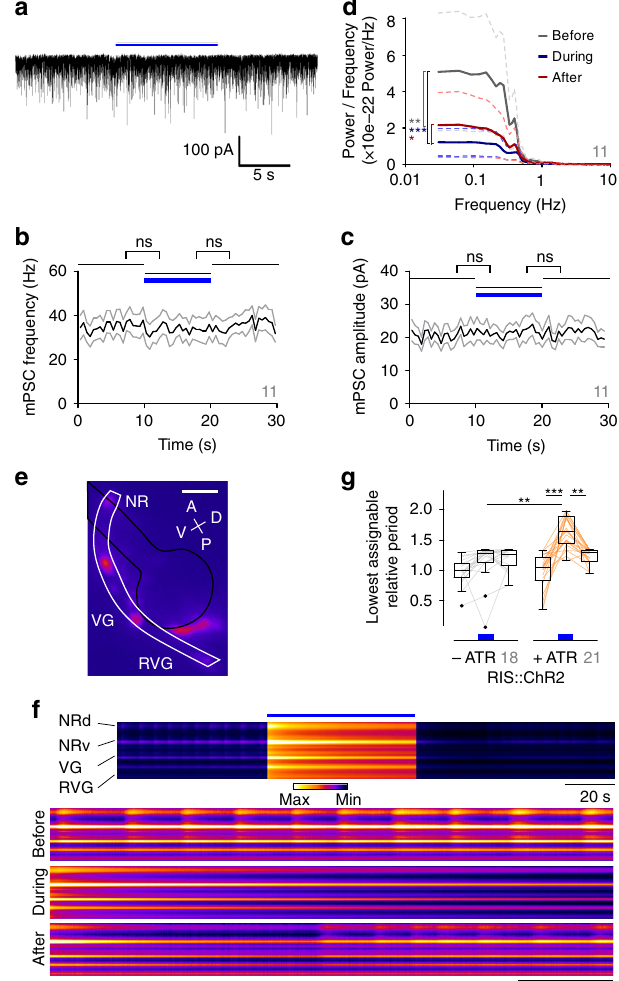
Fig. 3 RIS photoactivation suppressed motor neuron (MN) synchrony and Ca 2 + oscillations. a Exemplary voltage clamp recording of BWM cell, postsynaptic to MNs. Blue bar denotes RIS::ChR2 photostimulation b , c Analysis (mean±SEM) of mPSC frequency ( b ) and amplitude ( c ). Blue bar: Illumination period; n = 11 animals. d Fourier transform with multi-taper analysis of mPSC events across the observed frequencies. Mean (solid lines) ±SEM (dashed lines) of the periods before, during, and after RIS photostimulation of n = 11 animals. e RCaMP fl uorescence in cholinergic neurons in the head with region of interest from dorsal nerve ring (NR; d and v denote dorsal and ventral portions in f ) through ventral to retrovesicular ganglia (VG, RVG) marked in white; black: pharynx outline. Scale bar = 25 µ m. For identity of cells imaged, see Supplementary Fig. 3A. f Kymograph representation of cholinergic neuron Ca 2 + dynamics from the dorsal NR to posterior RVG. Scale bars, upper = 20s, lower = 10s; blue bar: illumination period, lower three panels show expanded views. g Autocorrelation analysis (as in Fig. 2e); distribution of mean change in Ca 2 + oscillation period in cholinergic neurons, per animal, relative to before RIS photoactivation. When no oscillations occurred, the duration of photostimulation (60s) was assumed as minimal period. Number of animals indicated in gray. *** p ≤ 0.001; ** p ≤ 0.01; * p ≤ 0.05; statistical signi fi cance tested by two-way ANOVA in d and ANOVA, Bartlett ’ s test, and Bonferroni ’ s multiple comparison test in g